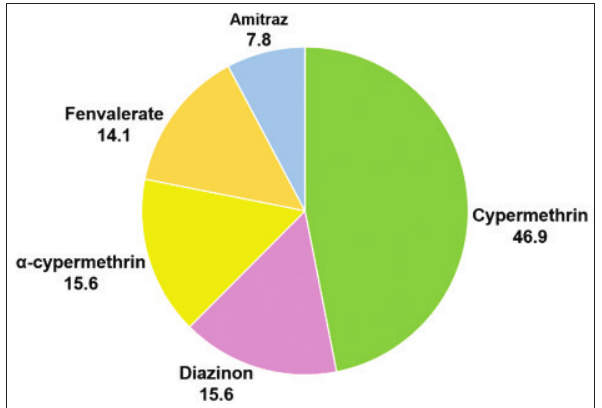
Figure-4: Pie chart showing the percentage of chemicals used in the control of the camel ticks Hyalomma dromedarii . Presented data are results of a survey of 70 camel owners in Al Ain, United Arab Emirates.